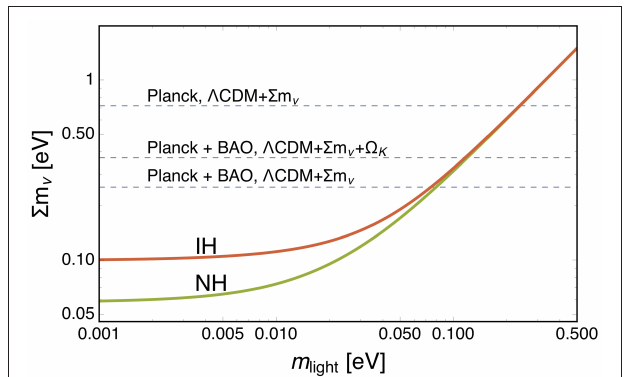
FIGURE 4 | Sum of neutrino masses 6 m ν as a function of the mass m light of the lightest neutrino eigenstate, for normal (green) or inverted (red) hierarchy. The horizontal dashed lines show 95% CL upper limits for different dataset 6 m ν combinations, from top to bottom: PlanckTT lowP in the 3 CDM + + 6 m ν (cid:127) K model, model, PlanckTT lowP BAO in the 3 CDM + + + + 6 m ν PlanckTT lowP BAO in the 3 CDM + + +